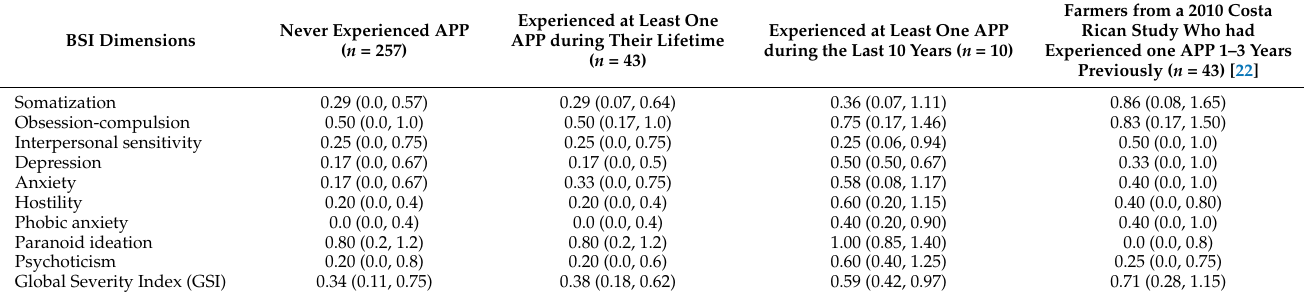
Table 3. Median (interquartile range (IQR)) Brief Symptom Inventory (BSI) descriptive parameters in farmers who reported a pesticide poisoning vs. those who did not. A higher score corresponds to a higher frequency of symptoms in that dimension in the past month in the study population. The last column compares the data from this study with that of a different 2010 study in Costa Rican farmers that administered the BSI to farmers that had experienced an acute pesticide poisoning (APP) in the previous one to three years [22].